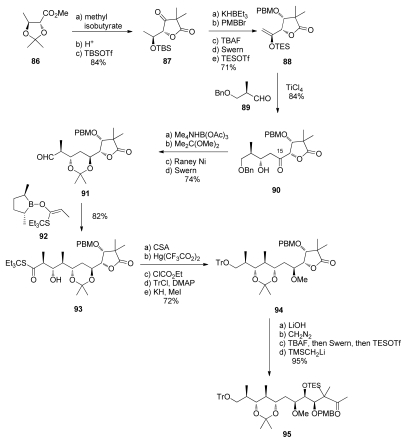
Preparation of 95.